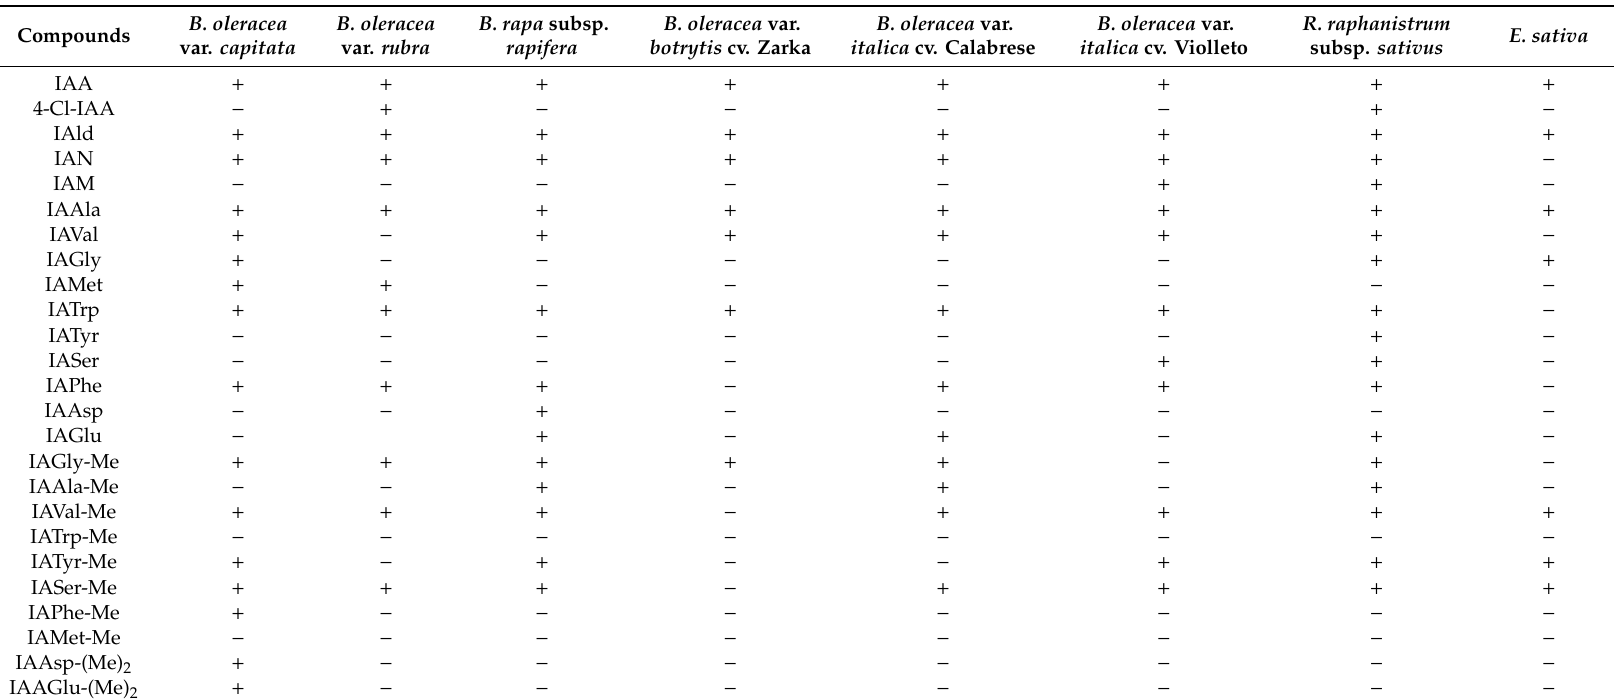
Table 2. IAA, IAA metabolites, and IAA amide conjugates with acid amino in eight members of the Brassicaceae